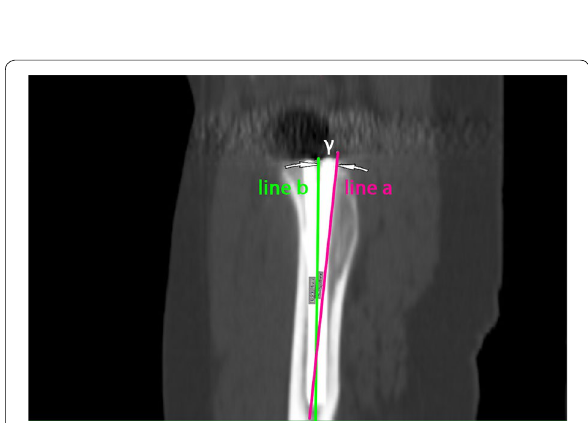
Fig. 4 Measurement of the alignment of the implant in relation to the femoral shaft axis in the sagital plane (tilt). Line a represents the femoral shaft axis, line b the implant shaft axis. In this case the alignment angle γ was 2.6° anterior